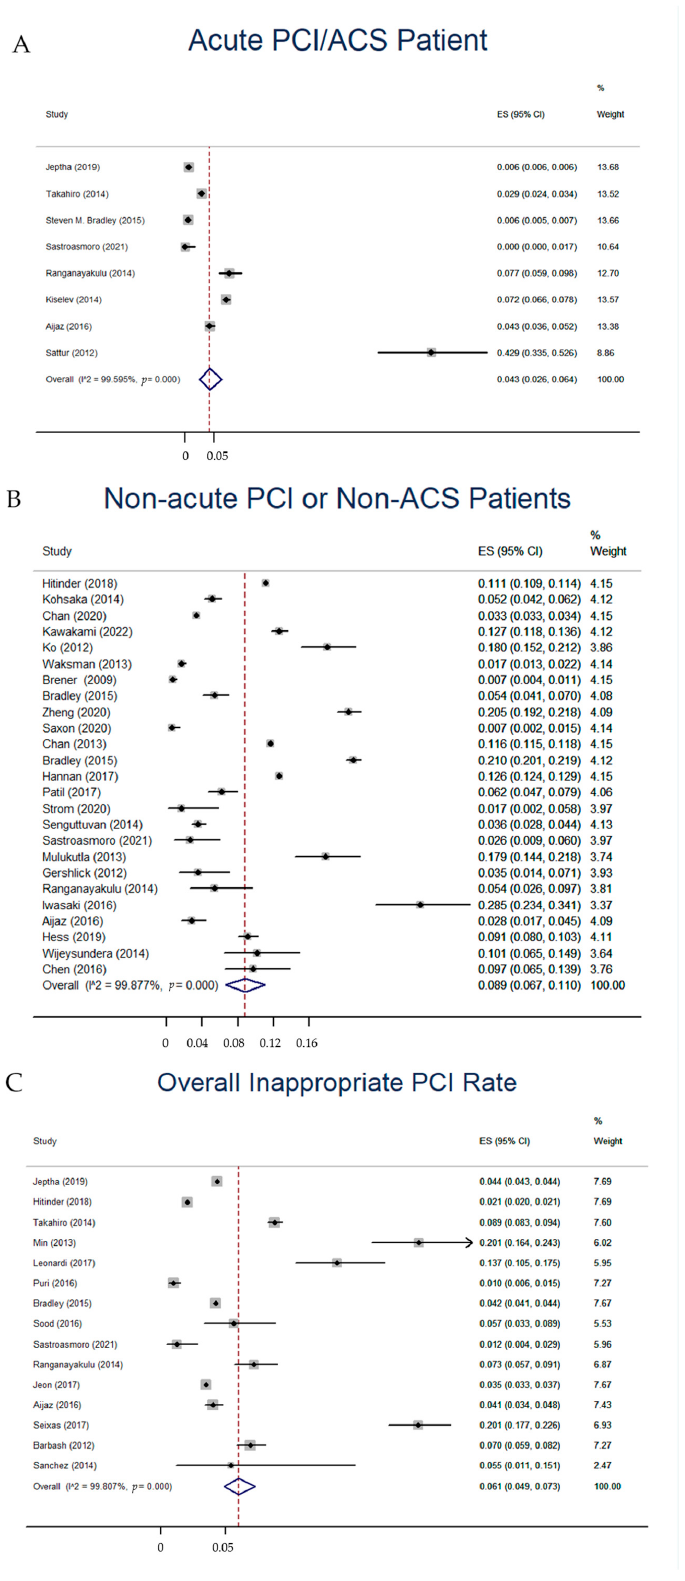
Figure 2. Forest plot for the meta-analysis of the inappropriate rate of PCI. ( A ) Pooled inappropriate PCI rate of acute PCI/ACS patients. ( B ) Pooled inappropriate PCI rate of non-acute/elective PCI or non-ACS/SIHD patients. ( C ) Pooled inappropriate PCI rate among patients in whole/PCI urgency not